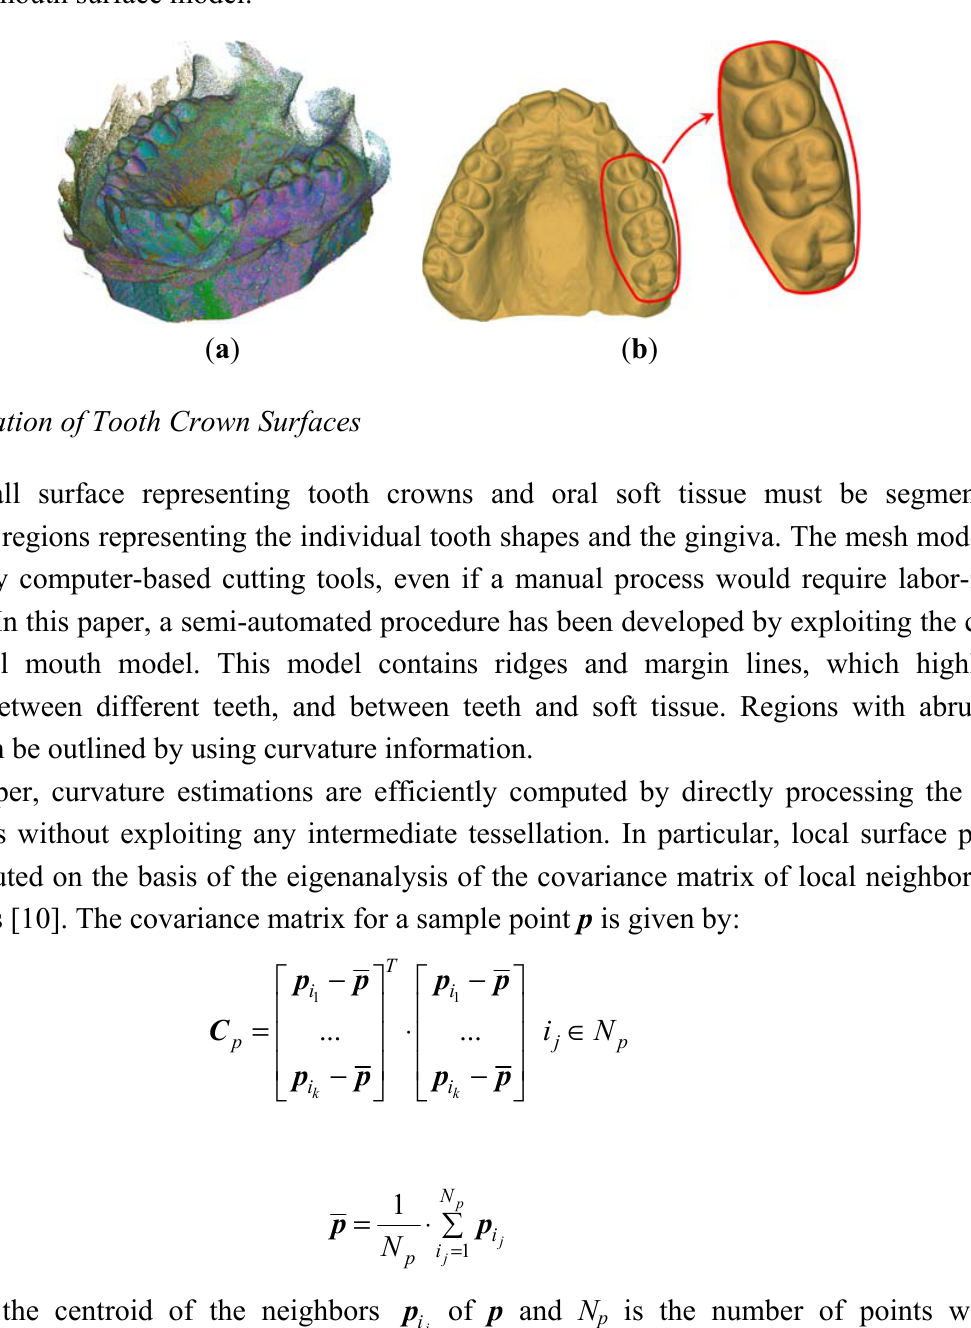
Figure 5. ( a ) Fusion of the different views of the two distinct data sets. ( b ) Corresponding digital mouth surface